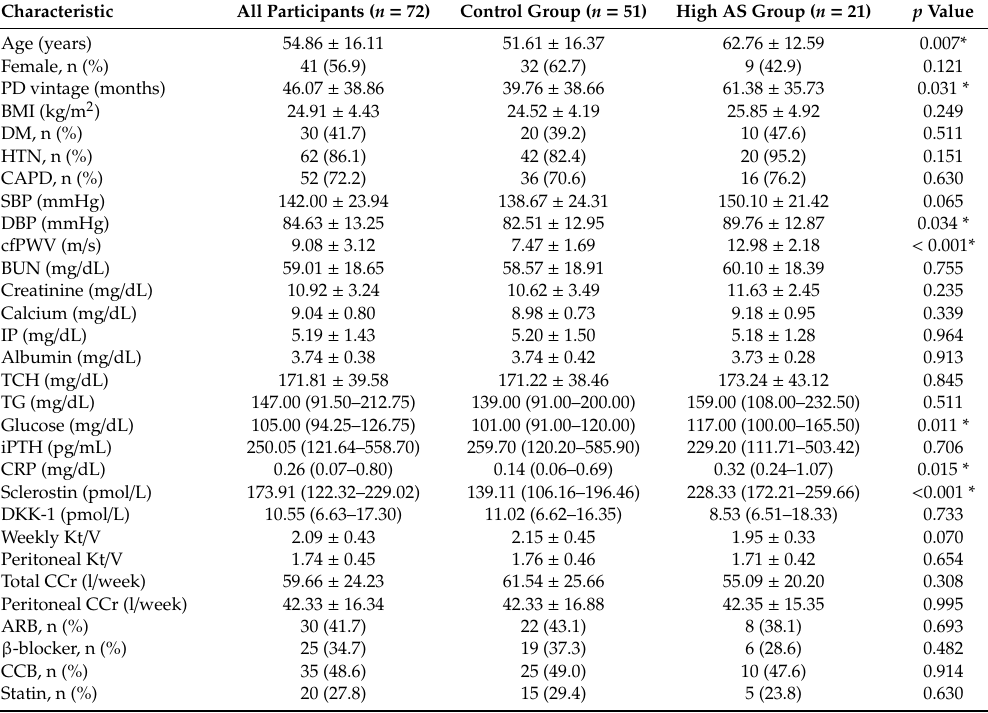
Table 3. Clinical variable of the PD patients with high AS and control